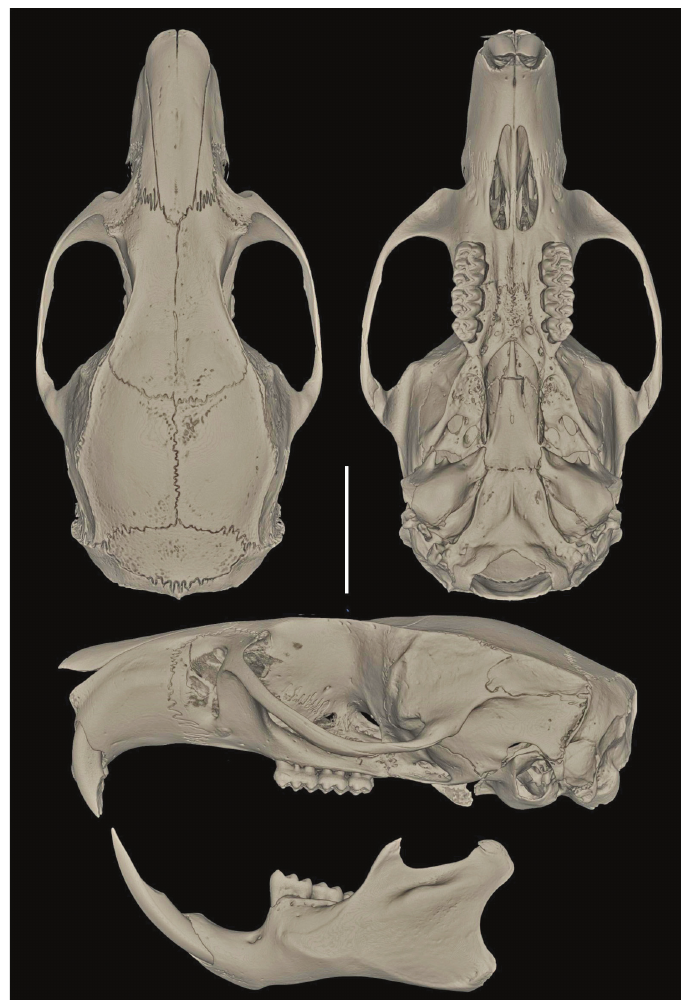
Figure 4. Three-dimensional reconstruction of the skull of Mindomys kutuku sp. nov. based on micro-CT data of the holotype (MECN 5809; Cordillera de Kutukú, Ecuador): cranium in dorsal, ventral, and lateral view, and left hemimandible in labial view. Scale bar: 10